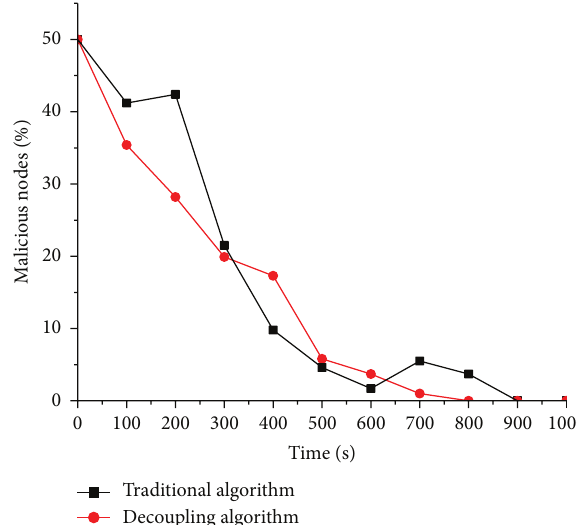
Figure 3: Percentage of the malicious suspicious virtual machine node is 30%.